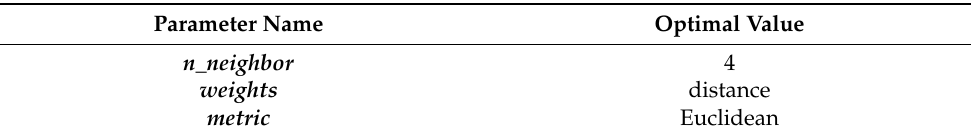
Table 8. Optimal parameter combination of kNN.